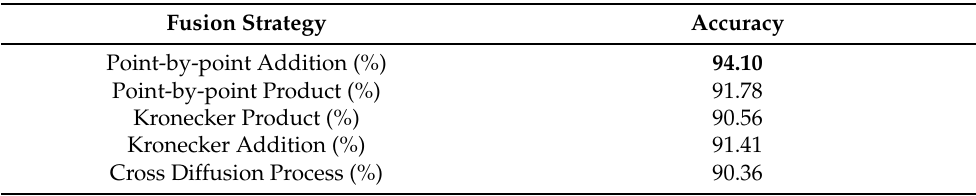
Figure 4. Visualization of fusion graph and other graphs. The fusion graph fuses the topological, functional, and causal graphs. The fusion strategy is point-by-point addition. Table 4. The influence of different fusion strategies on SEED dataset. The best results are marked in